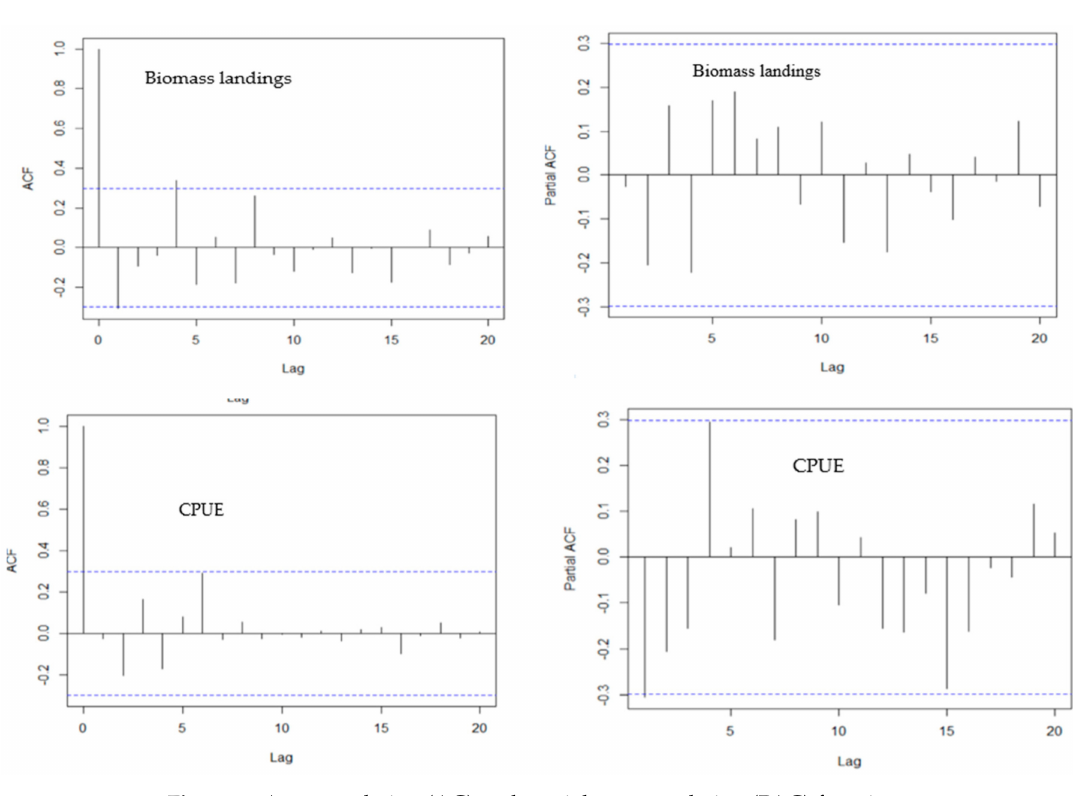
Figure 5. Autocorrelation (AC) and partial autocorrelation (PAC) functions.